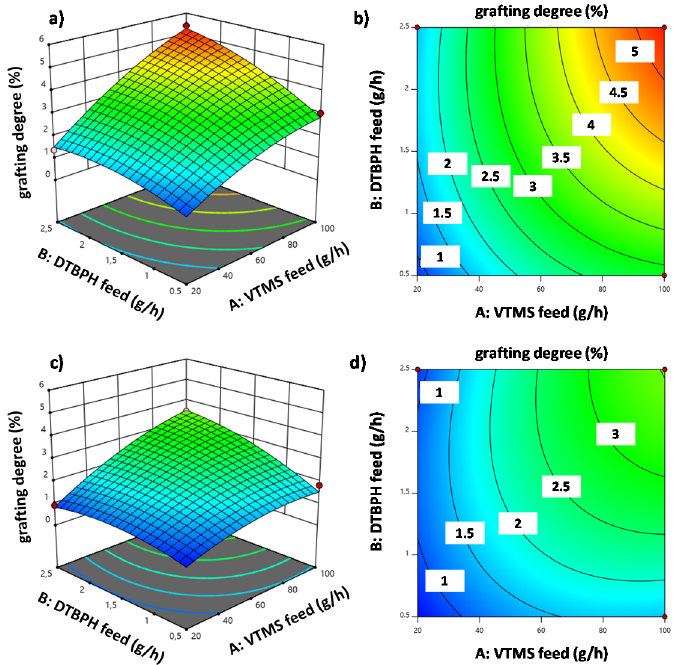
Figure 5. Grafting degree as a function of the VTMS and 2,5-dimethyl-2,5-di(tert-butylperoxy) hexane (DTBPH) feed rates for two scenarios: (1) 3D response surface plot ( a ) and corresponding contour line plot ( b ) at a low EOC feed and a high-temperature increase, and (2) 3D response surface plot ( c ) and corresponding contour line plot ( d ) at a high EOC feed and a low-temperature increase.